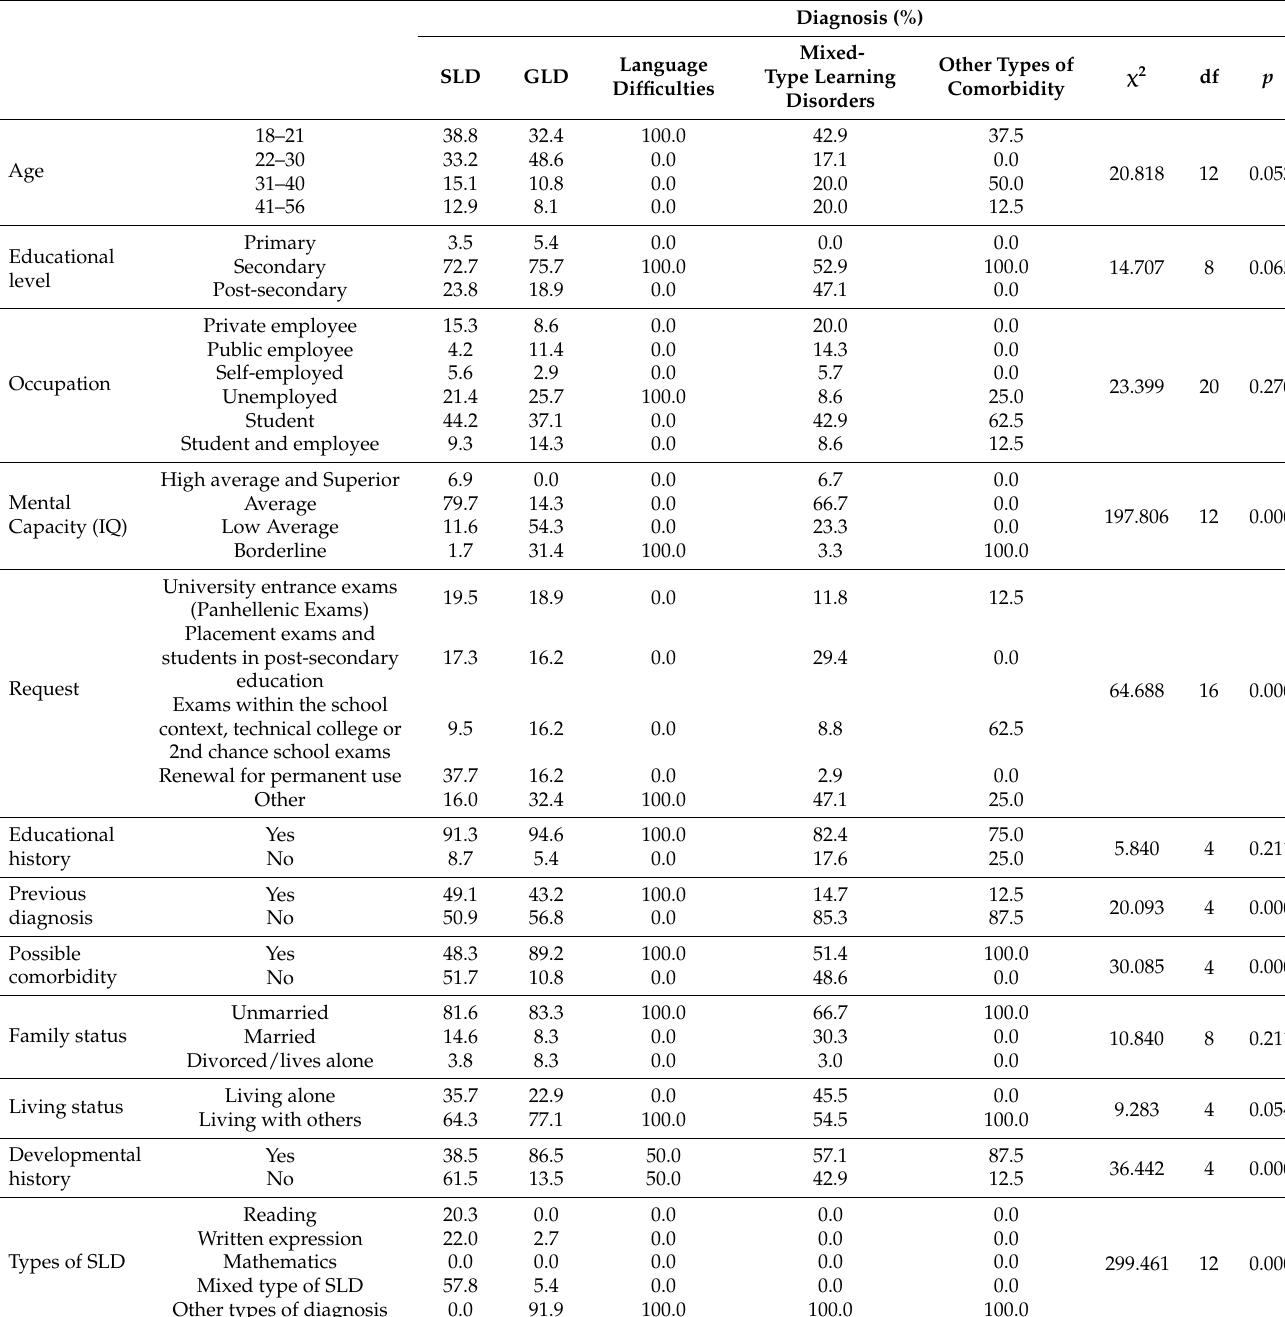
Table A4. Relationship of the Diagnosis of the assessed adults with the other